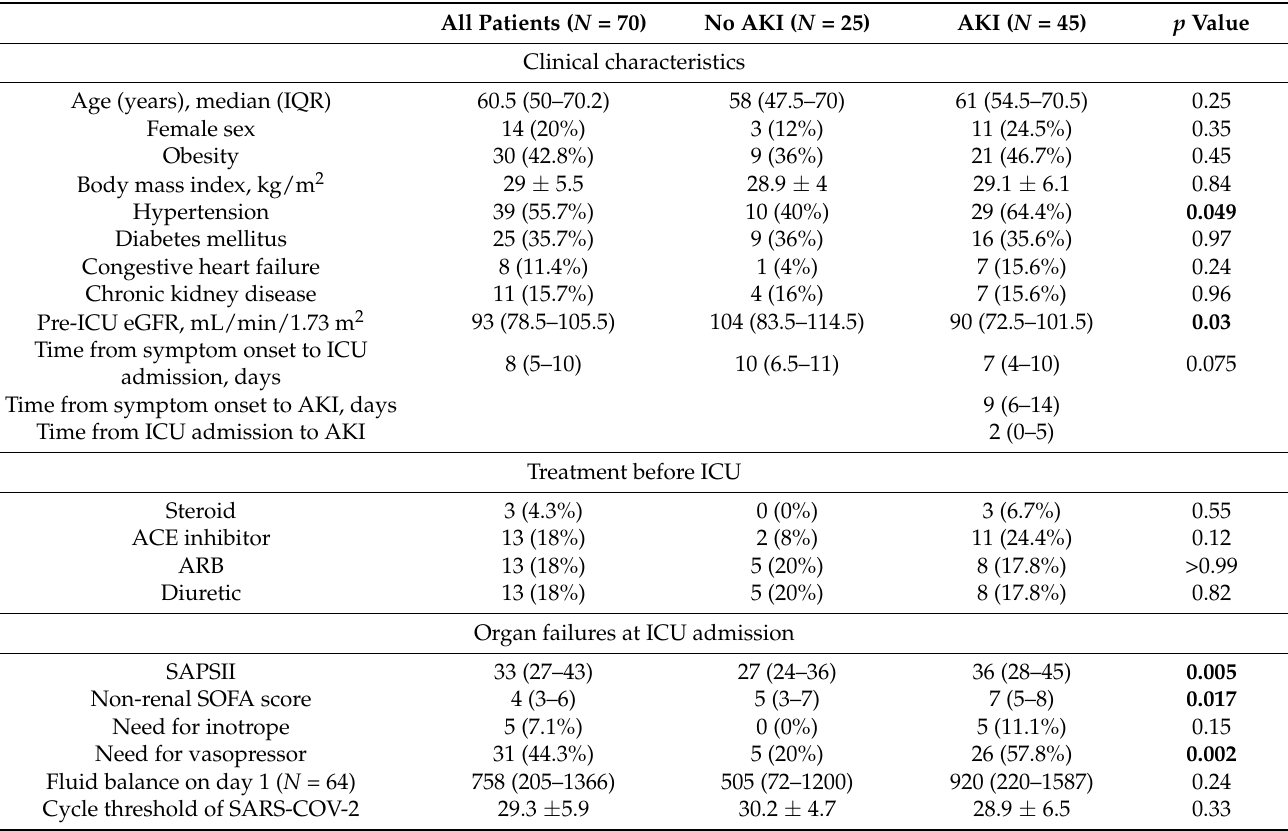
Table 1. Characteristics of critically-ill COVID-19 patients according to occurrence of acute kidney injury